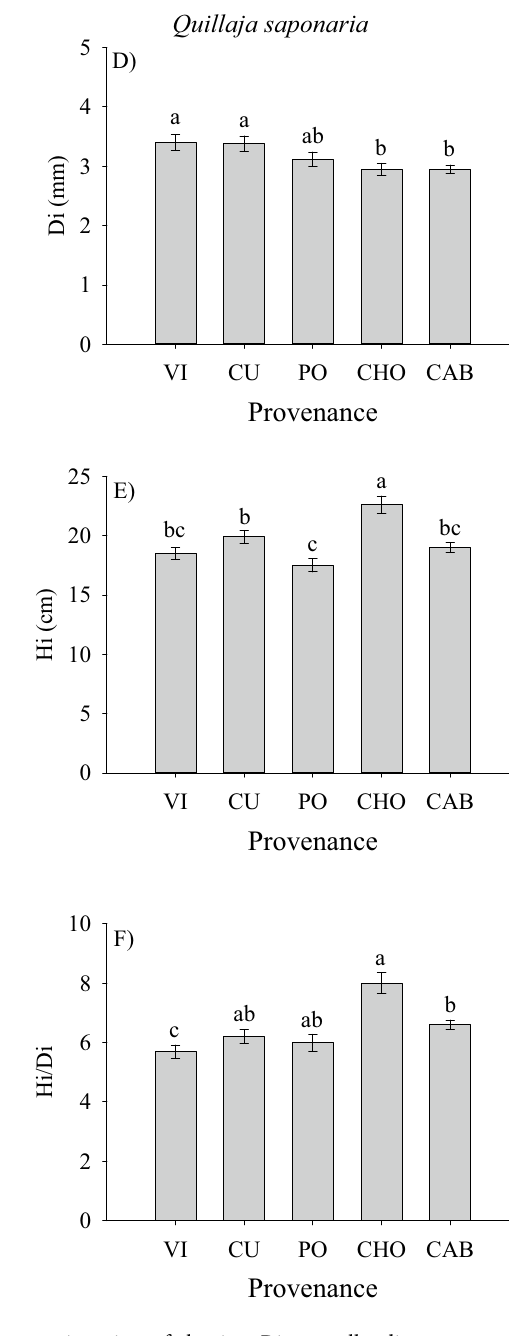
Figure 2. Seedling characteristics for C . alba and Q . saponaria at time of planting. Di root collar diameter, Hi height, Hi/Di height to diameter ratio. Different letters indicate significant differences among provenances (Tukey test; p ≤ 0.05). The error bars indicate the standard error. Codes for provenances are according to Table 1. Provenances are ordered from left to right by latitude of